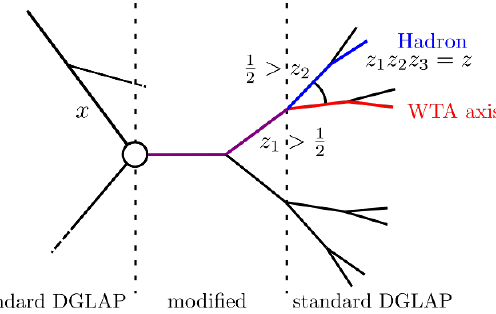
Figure 4 . The parton shower picture for TMD fragmentation with the WTA axis. At each splitting the axis (purple/red) follows the largest momentum fraction. The angular ordering implies that the hadron must follow the same branch (purple) until the splitting angle drops below k=E J , after which it can take a di(cid:11)erent branch